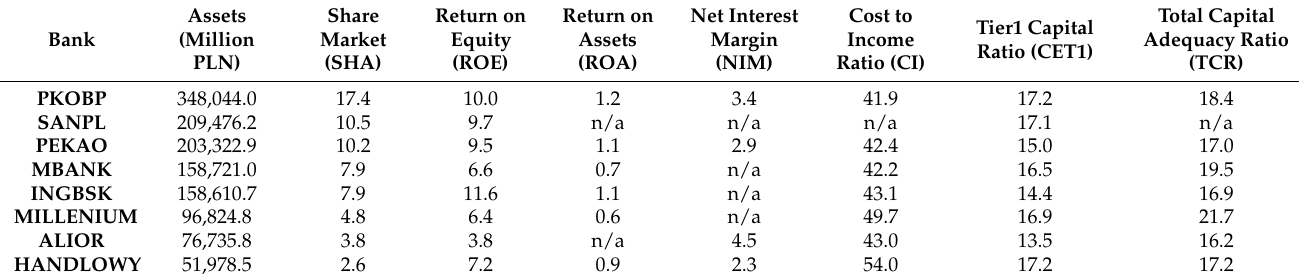
Table 3. The characteristic of the sampled banks (state as of 31 December